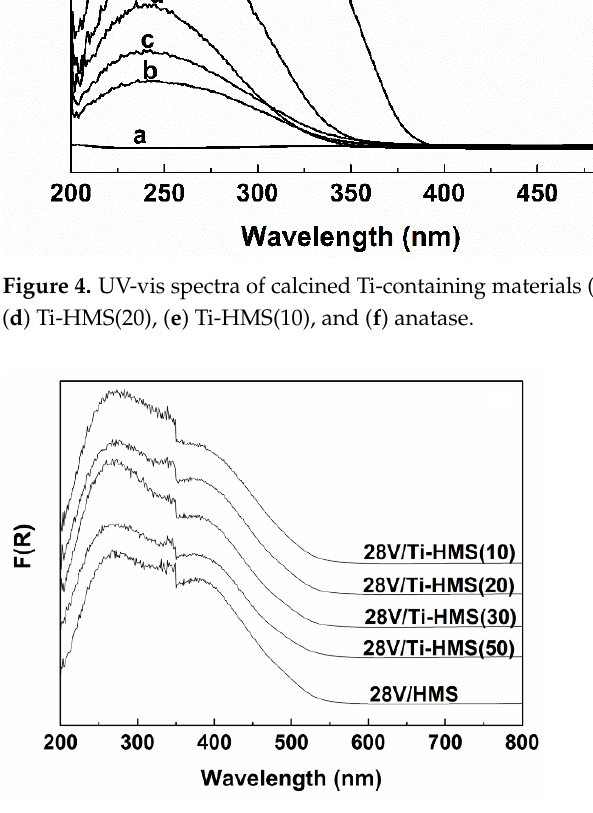
Figure 6. UV-vis spectra of catalysts with different supports. ( a ) 28V/HMS. ( b ) 28V/Ti-HMS (30). The Raman spectra of the samples in the region of 200 to 1200 cm −1 are presented in Figure 7. The distinctive Raman characteristics of crystalline V 2 O 5 are the bands centered at 282, 301, 405, 478, 525, 700, and 995 cm −1 , which appear for all samples [31] and thus agree well with the XRD results as shown in Figure 2 where well-resolved V 2 O 5 patterns are observed. It is notable that a new band at 1035 cm −1 , which is identified as the terminal mono-oxo V=O bond of isolated surface vanadium species bonded to the surface silica species (O=V(OSi) 3 ) [60], is only observed for the Ti-modified catalysts. This finding fur- ther confirms that the dispersion of V 2 O 5 over the Ti-modified catalysts, especially for V- Ti-HMS(30), is better than that over the Ti-free catalysts. This result is consistent with the outcomes of UV-vis DRS studies.